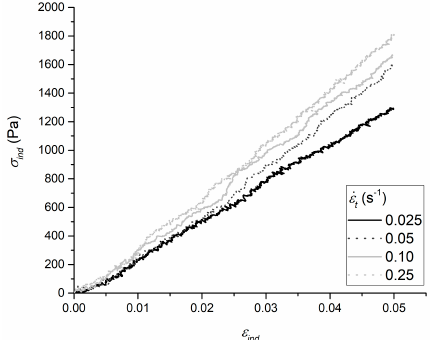
Figure 1. Examples of indentation stress-strain curves obtained testing 25 mM of GTA-crosslinked gelatin hydrogels. Sample viscoelasticity is reflected in the increase of apparent elastic modulus (i.e., stress versus strain slope) with increasing strain rate.